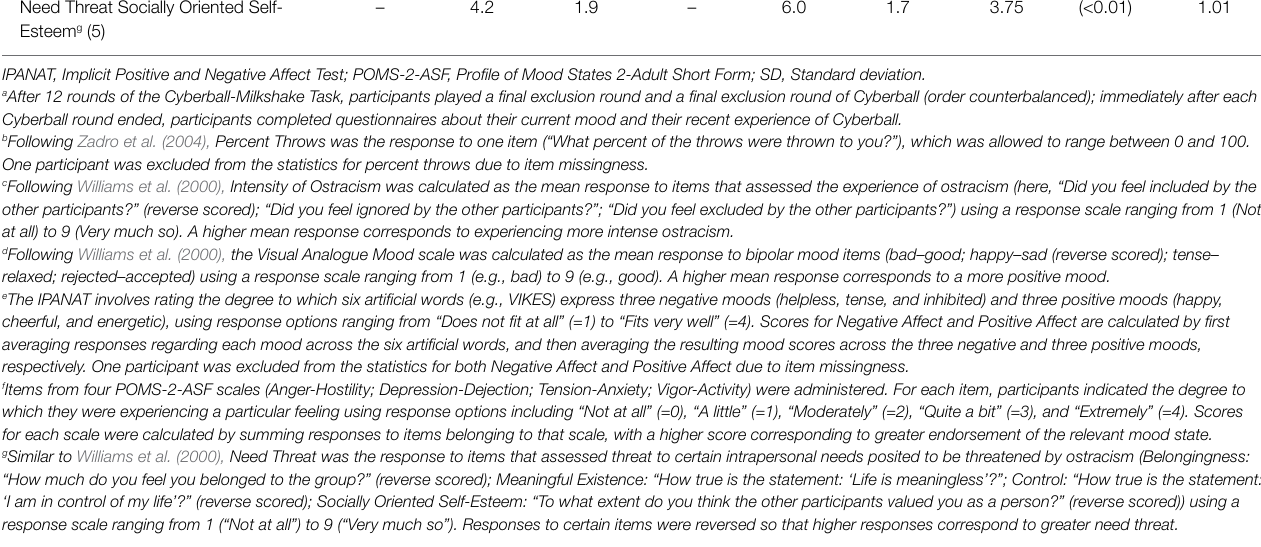
Variable name (order in which